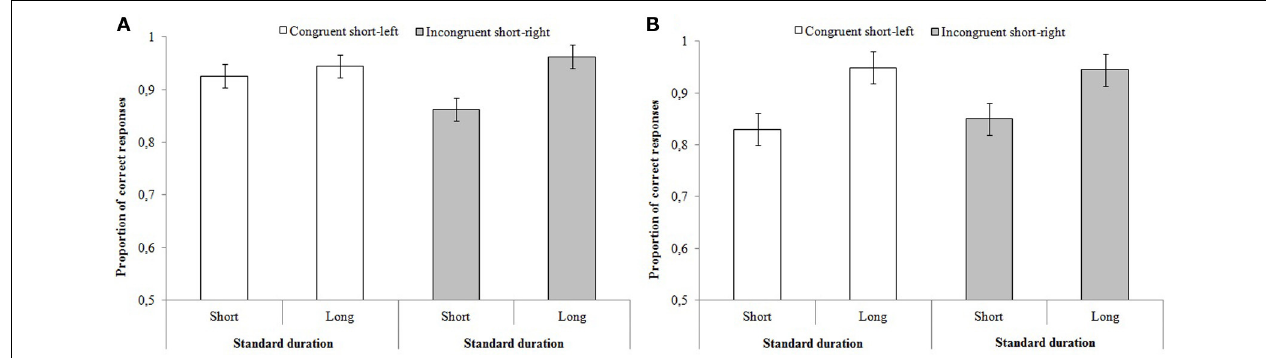
FIGURE 5 | Design of the Experiment 2 (see Method). B, “Breve” (short in Italian); L, “Lungo” (long in Italian).